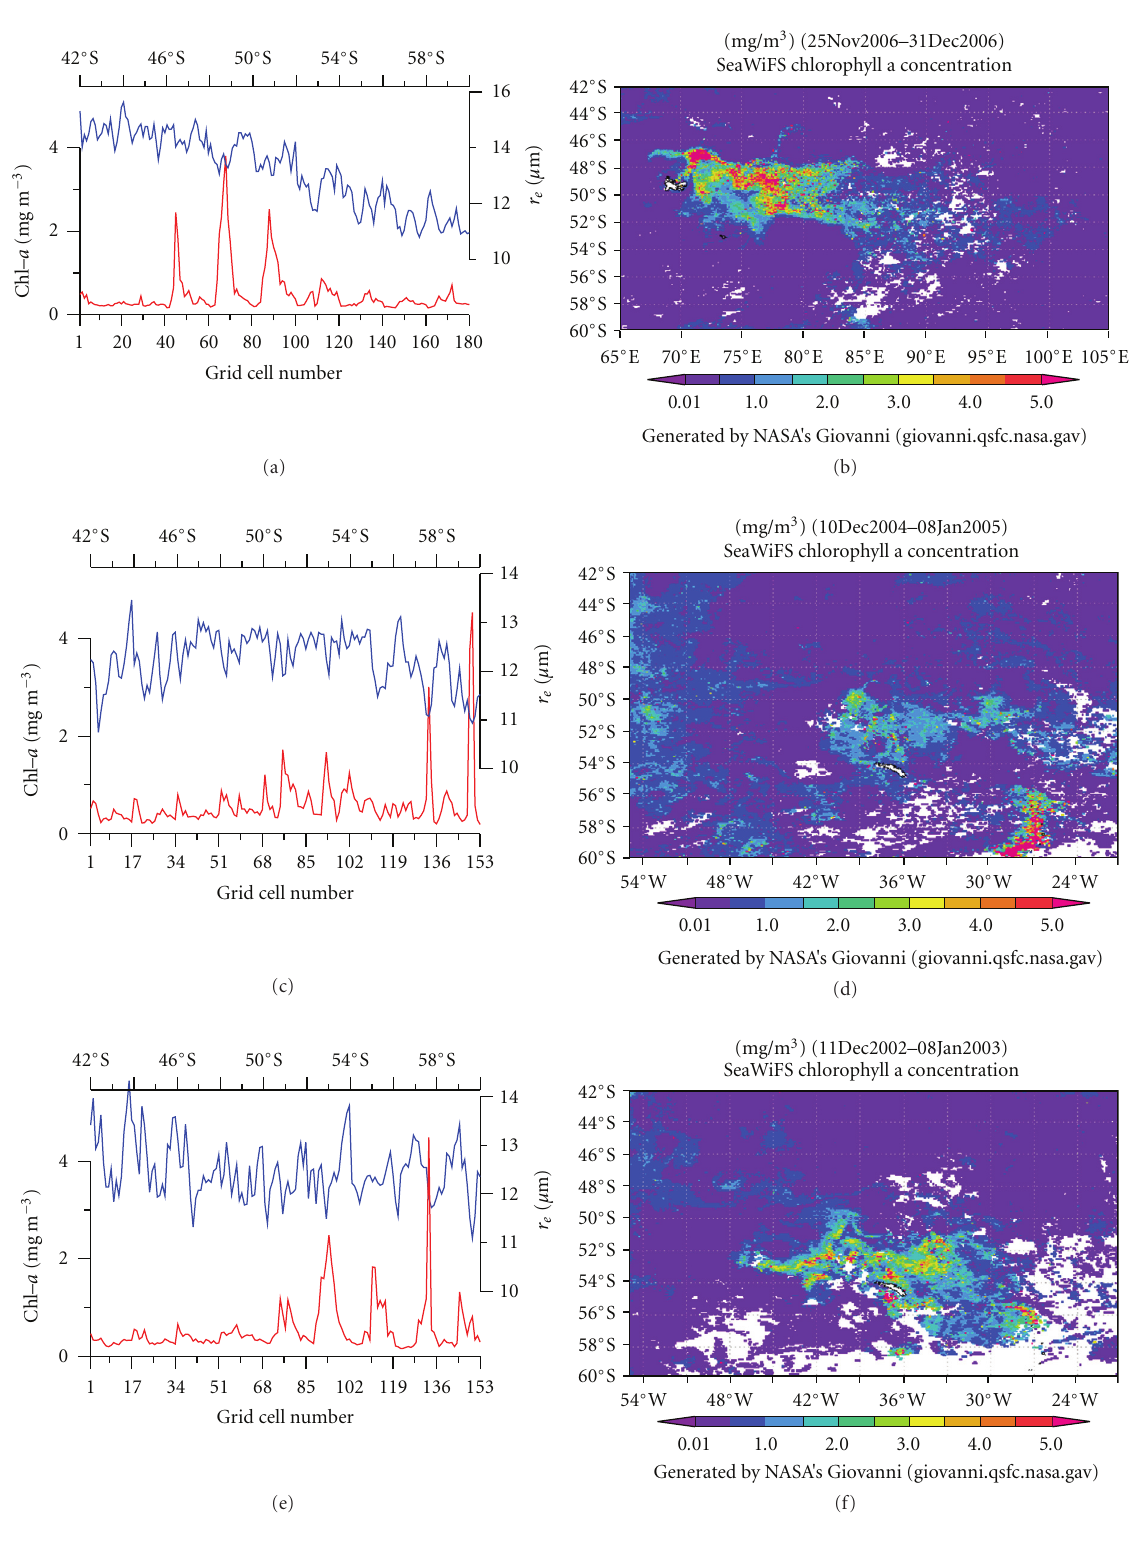
Figure 3: The 2 ◦ × 2 ◦ square monthly averaged [Chl - a ] and r e data for Southern Indian Ocean for (a), (b) 25 November 2006–31 November 2006; Southern Atlantic Ocean for (c), (d) 10 December 2004–08 January 2005; and Southern Atlantic Ocean for (e),(f) 11 December 2002– 08 January 2003. The white color over the ocean denotes the missing data due to clouds. The Kerguelen Island (49.25 ◦ S–69.58 ◦ E) and the South Georgia Island (54.25 ◦ S, 36.75 ◦ W) are shown by black contours. The method is adopted from Meskhidze and Nenes [32]. The images and data used in this figure were acquired using the GES-DISC Interactive Online Visualization ANd aNalysis Infrastructure (Giovanni) as part of the NASA’s Goddard Earth Sciences (GES) Data and Information Services Center